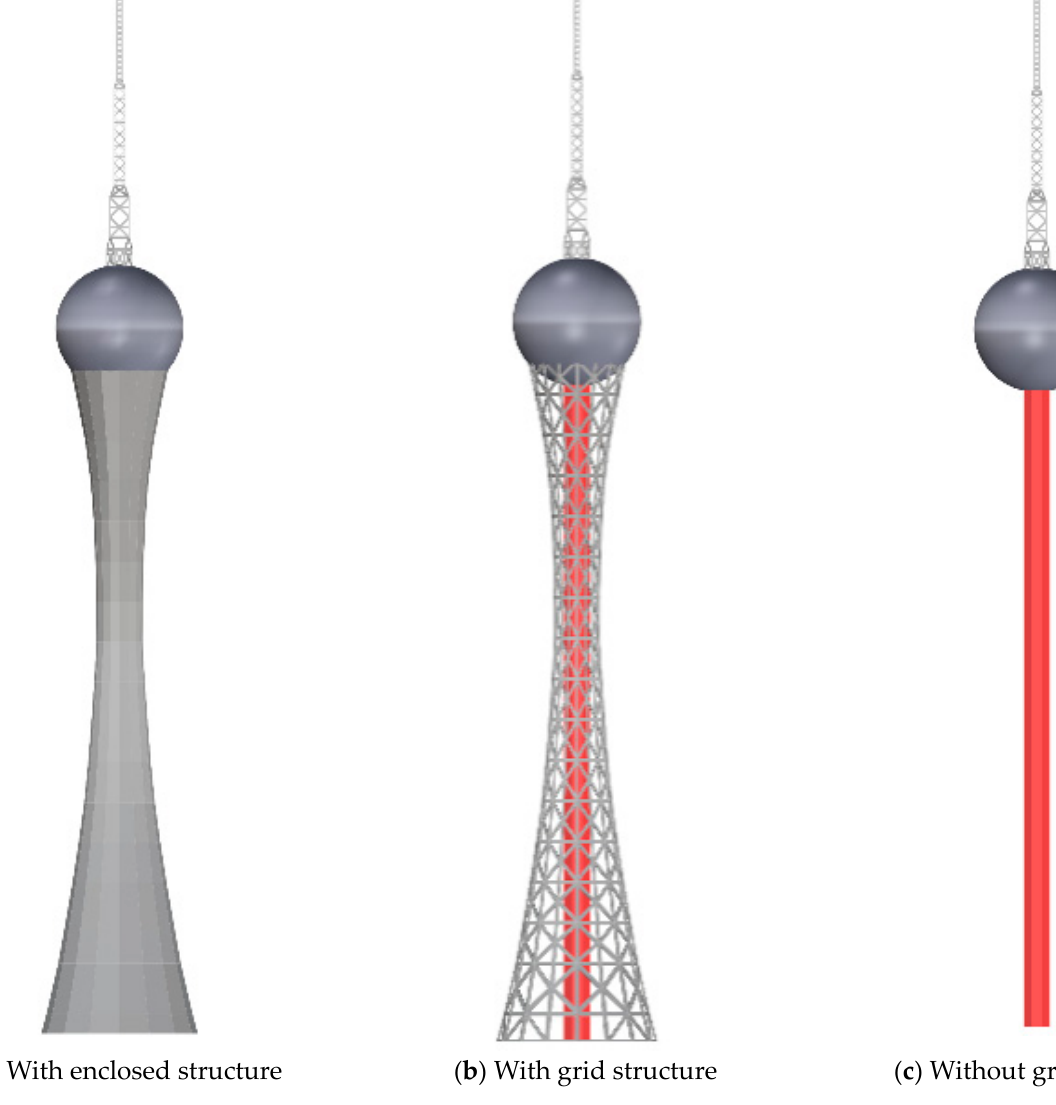
Figure 2. Three types of TV tower models.